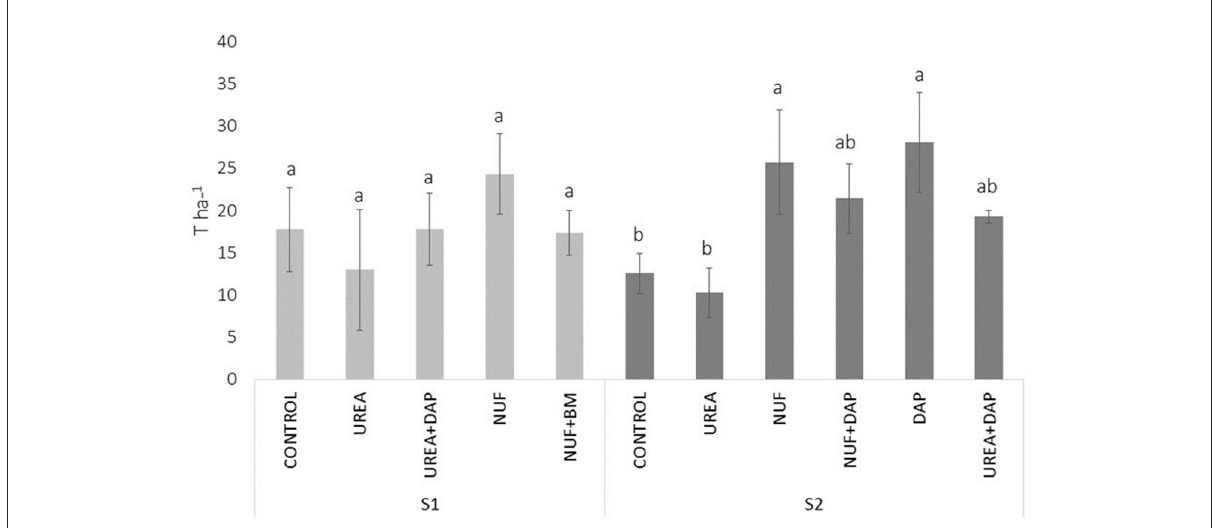
FIGURE2 Cabbage yield at the mother site field trial. Values are means with bars representing standard errors ( n = 3). S1 = season 1, S2 = season 2. Bars with different letters (within each season) are significantly different ( p ≤